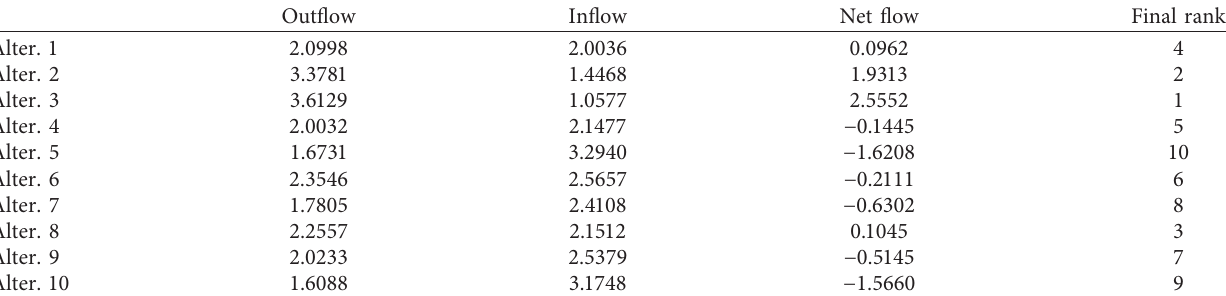
Table 14: The outflow, inflow, net flow, and final rank.